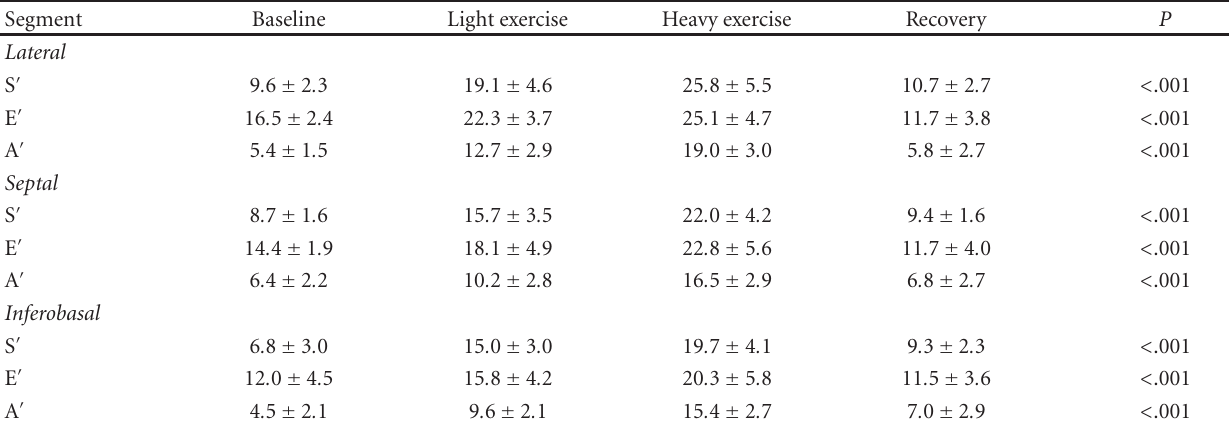
Table 3: Changes in tissue Doppler velocities during exercise.